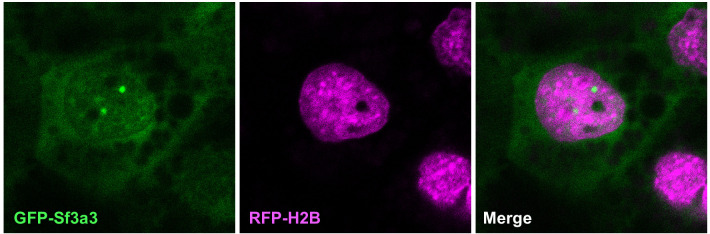
Sf3a3-GFP (green) also localizes to speckles within the nucleus (labeled with RFP-Histone2B, red) in a Xenopus MCC.